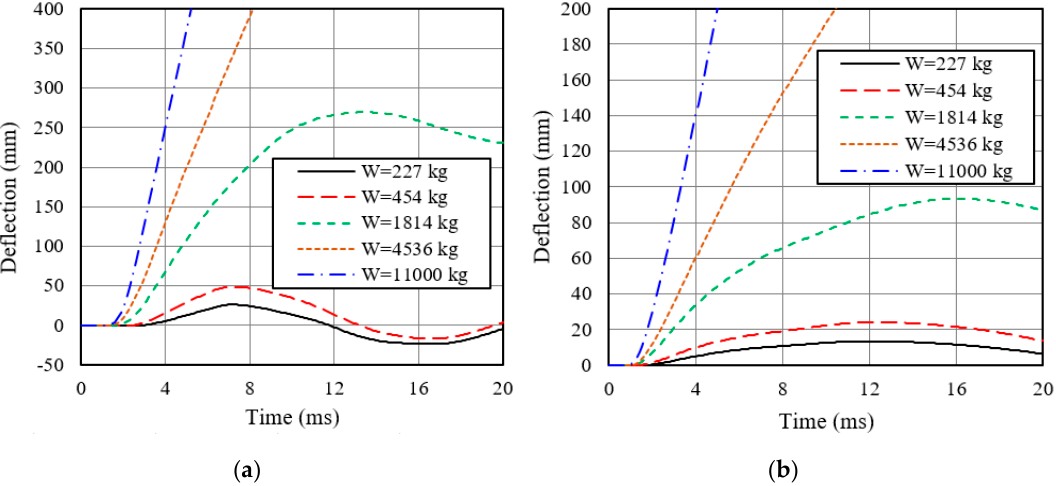
Figure 15. Deflection histories of beam and column for plate-reinforced large CFT connection. ( a ) Beam; ( b ) column.